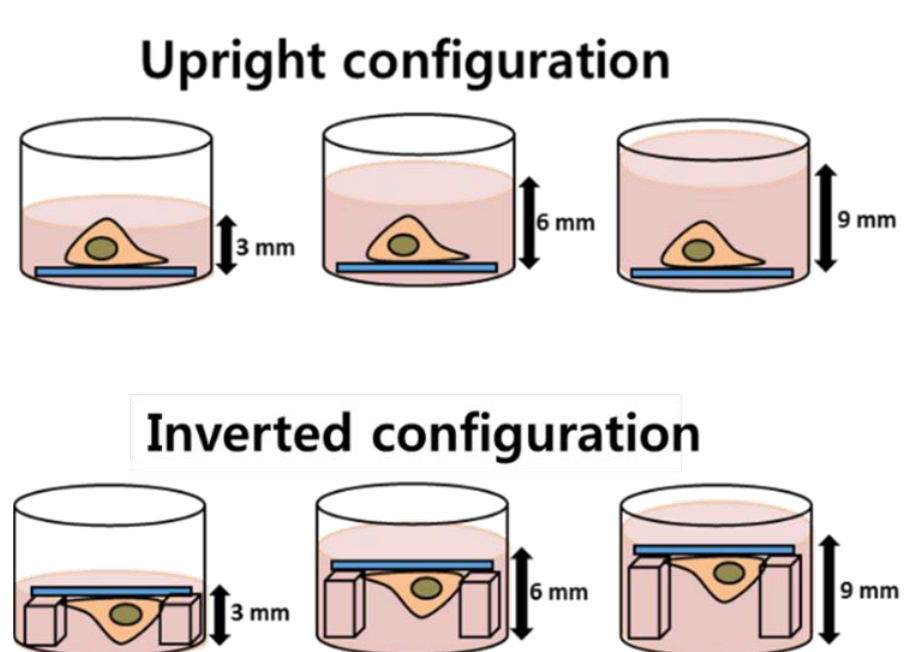
Figure 1. Illustration of cell configurations (upright and inverted) with different media heights: 3, 6, and 9 mm.